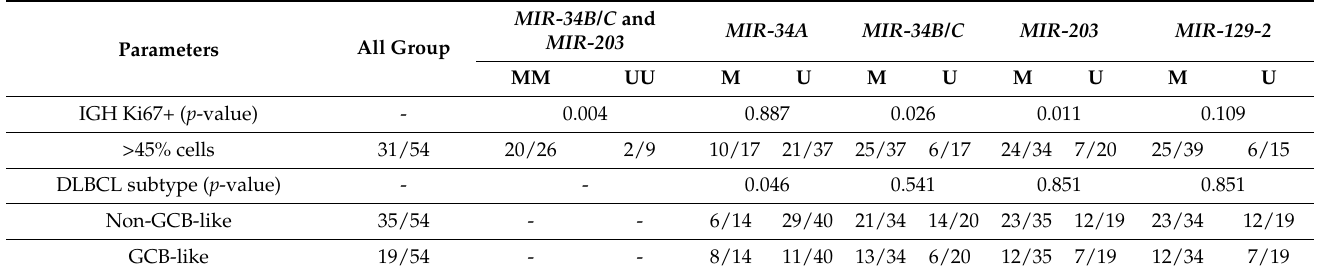
Table 4. Immunohistochemical parameters of the DLBCL samples.